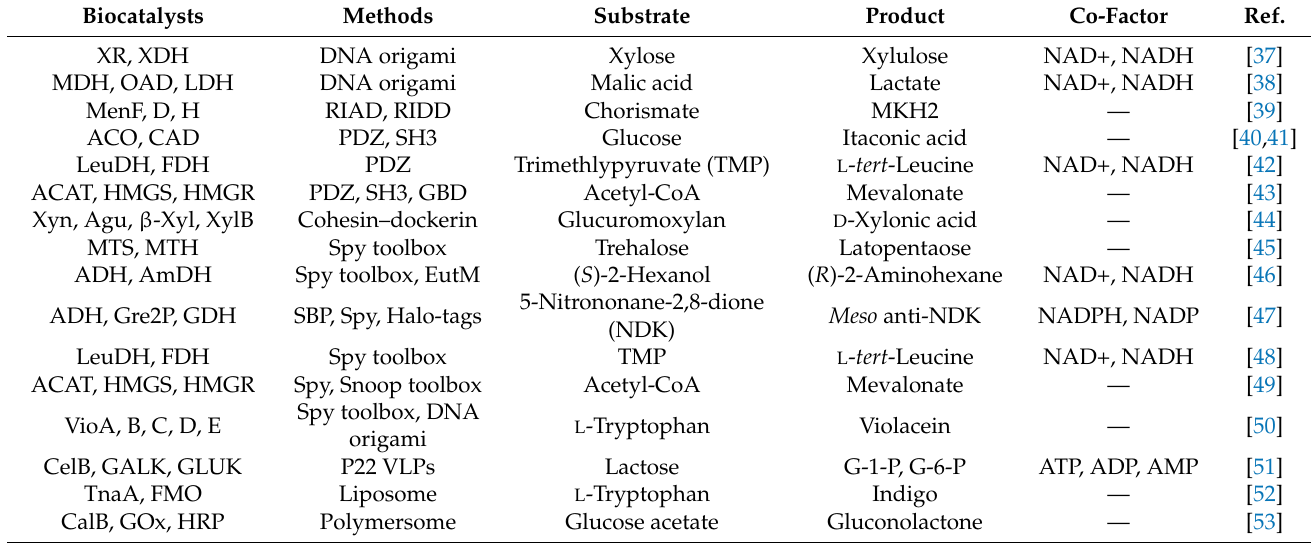
Table 1. Representative examples of enzyme systems co-localized by the different approaches discussed in this contribution.